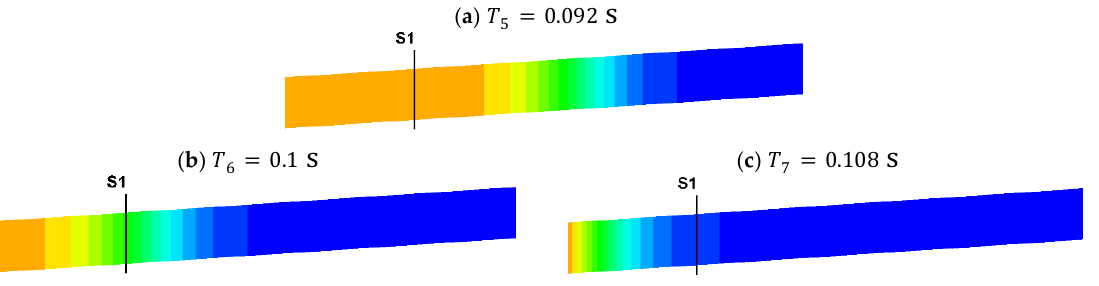
Figure 18. Pressure field evolution on the axis plane of the pipeline ( 𝑇 5 = 0.092 s , 𝑇 6 = 0.1 s , and 𝑇 7 = 0.108 s ).